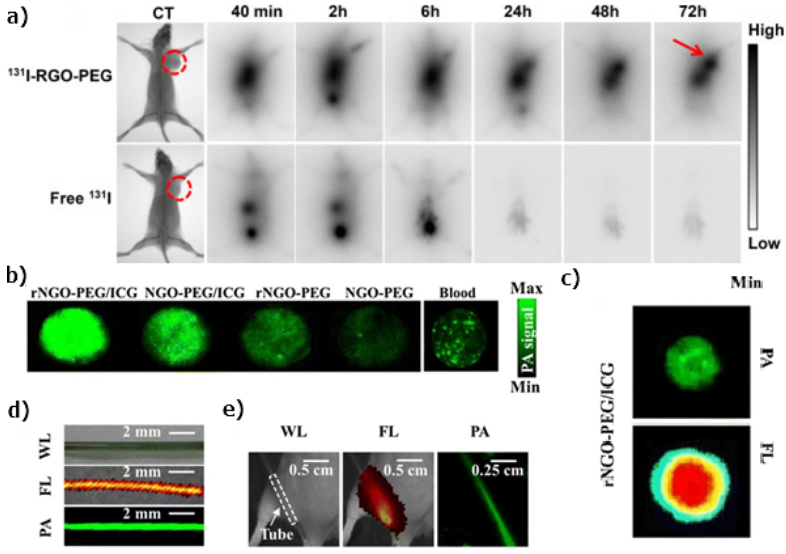
Figure 6. ( a ) In vivo behaviors of 131 I–rGO–PEG. Gamma imaging of mice bearing 4T1 tumors after i.v. injection of 131 I–rGO–PEG and free 131 I at the same radioactivity dose. 131 I–rGO–PEG can passively accumulate in the tumor via the enhanced permeability and retention (EPR) effect, while 131 I can only be rapidly excreted from the body. Tumors are highlighted by circles in X-ray imaging and arrows in gamma imaging [164]. Copyright 2015, with permission from Elsevier. ( b ) Photoacoustic images of NGO–PEG, rNGO–PEG, NGO–PEG/ICG, and rNGO–PEG/ICG with the same GO concentration and whole blood. ( c ) Photoacoustic and FL images of rNGO–PEG/ICG covered with 5 mm-thick agarose gel containing 0.5% intralipid. ( d ) White light (WL), FL, and PA MAP images of a PE tube filled with rNGO–PEG/ICG. ( e ) White light, FL, and PA MAP images of a mouse with the rNGO– PEG/ICG-filled PE tube implanted subcutaneously at the dorsal aspect of the leg. The white dashed box indicates the location of the tube